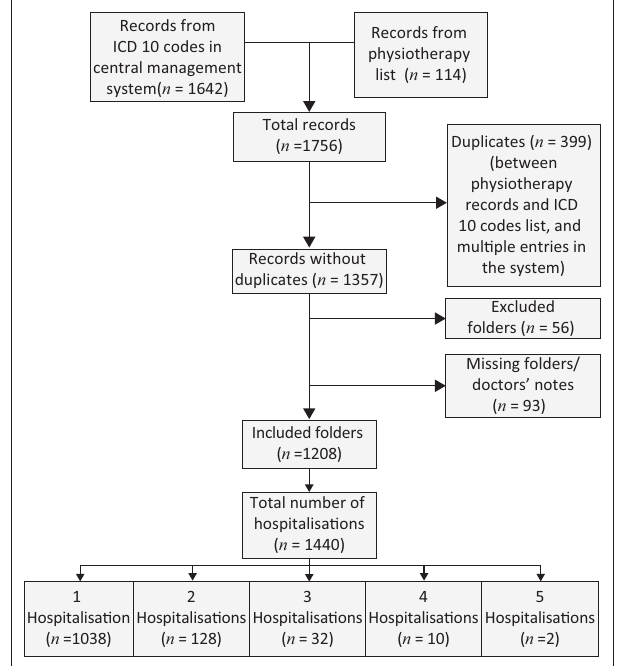
FIGURE 1: Folder review flow